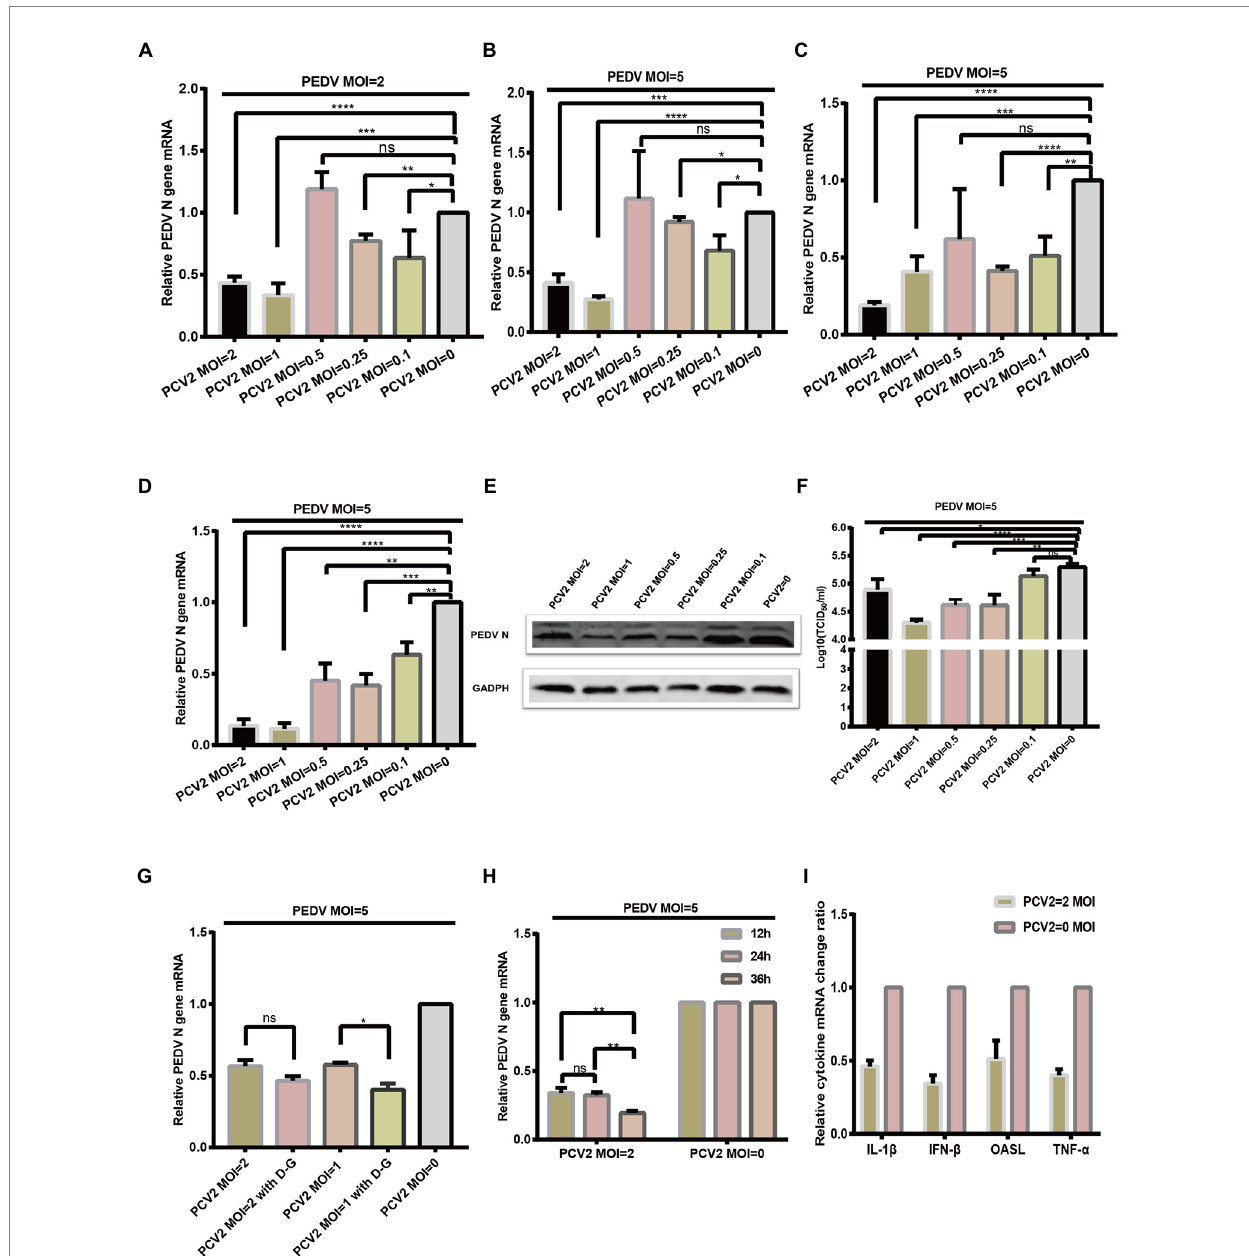
FIGURE 4 PCV2 reduces PEDV replication in IPI-FX cells. IPI-FX cells were inoculated PCV2d-LNHC at MOI = 2, 1, 0.5, 0.25, or 0.1 and incubated for 24 h. The same cells were then inoculated with PEDV (MOI = 2 or 5) and incubated for another 24 h. The cells were collected, the total RNA extracted, and the relative expression levels of nucleocapsid (N) mRNA in the PEDV–PCV2 dual-infected or PEDV-infected cells determined with RT–qPCR (A,B) . IPI-FX cells were inoculated PCV2a-LG or PCV2b-MDJ at MOI = 2, 1, 0.5, 0.25, or 0.1 and incubated for 24 h. The same cells were then inoculated with PEDV (MOI = 5) and incubated for another 24 h. The cells were collected, the total RNA extracted, and the relative expression levels of nucleocapsid (N) mRNA in the PEDV– PCV2 dual-infected or PEDV-infected cells determined with RT–qPCR (C,D) . IPI-FX cells were inoculated PCV2d-LNHC at MOI = 2, 1, 0.5, 0.25, or 0.1 and incubated for 24 h. The same cells were then inoculated with PEDV (MOI = 5) and incubated for another 24 h. After that, the cells were collected, lysed, and analyzed with western blotting using the antibodies indicated on the left. GADPH was loaded as the internal control (E) . IPI-FX cells were inoculated PCV2d-LNHC at MOI = 2, 1, 0.5, 0.25, or 0.1 and incubated for 24 h. The same cells were then inoculated with PEDV (MOI = 5) and incubated for another 24 h. The cells and supernatants were freeze–thawed to obtain viral stocks. The viral titers were determined with the Reed–Muench method (F) . IPI-FX cells were inoculated with PCV2d-LNHC (MOI = 2 or 1) and incubated for 24 h with or without d -glucosamine. The cells were then inoculated with PEDV (MOI = 5) and incubated for another 24 h. The cells were collected, the total RNA extracted, and the relative expression levels of nucleocapsid (N) mRNA in the PEDV–PCV2 dual-infected or PEDV-infected cells determined with RT–qPCR (G) . IPI-FX cells were inoculated with PCV2d-LNHC (MOI = 2) and incubated for the indicated times, and then with PEDV (MOI = 5) and incubated for another 24 h. The cells were collected, the total RNA extracted, and the relative expression levels of nucleocapsid (N) mRNA in the PEDV–PCV2 dual-infected or PEDV-infected cells determined with RT–qPCR (H) . IPI-FX cells were inoculated with PCV2d-LNHC (MOI = 2) and incubated for 24 h, and then with PEDV (MOI = 5) and incubated for another 24 h. The cells were collected, the total RNA extracted, and the relative expression levels of IL1 β , IFN- β , OASL, and TNF- α mRNAs in the PEDV–PCV2 dual-infected and PEDV-infected cells determined with RT–qPCR using specific primers for IL1 β , IFN- β , OASL, and TNF- α (I) . GADPH mRNA was used as the internal control for normalization (A–I) . Means ± standard deviations were calculated from three independent replicates of each